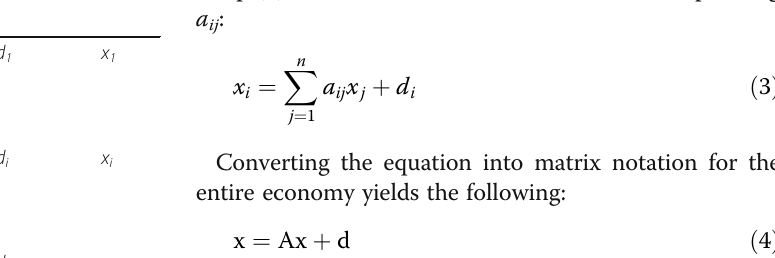
Total demand output (Buyer)